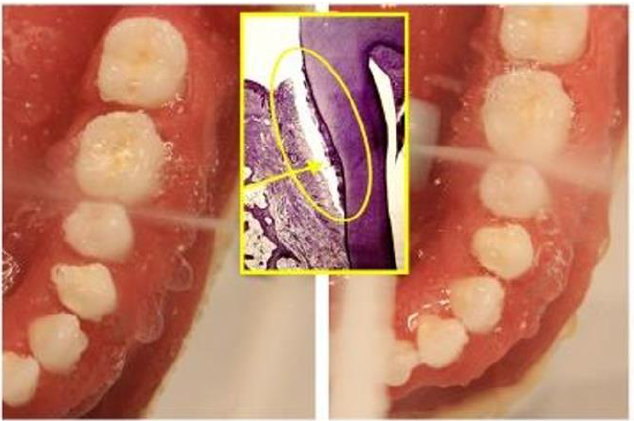
Figure 7. Oral irrigator in action, in order to remove sub-gingival biofilm.